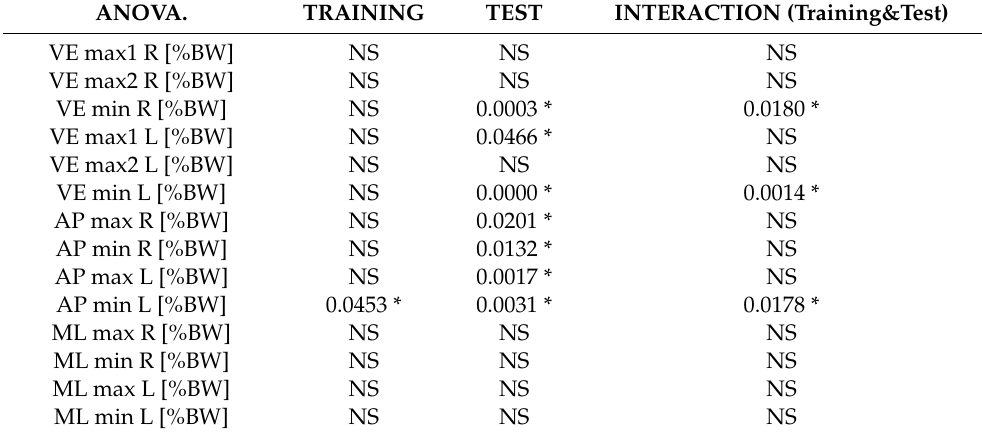
Table 8. Repeated-measures ANOVA for the ground reaction forces generated during the stance phase, taking into account the type of training and the test